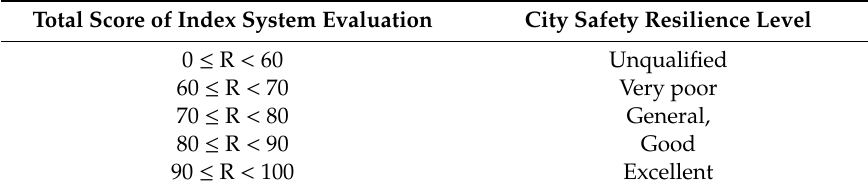
Table 3. City safety resilience